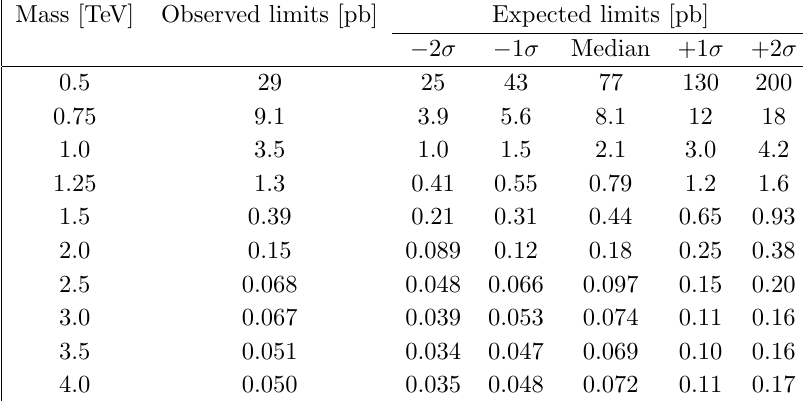
Table 7 . Expected and observed cross section limits at 95% CL, for the 10% width Z 0 resonance hypothesis.